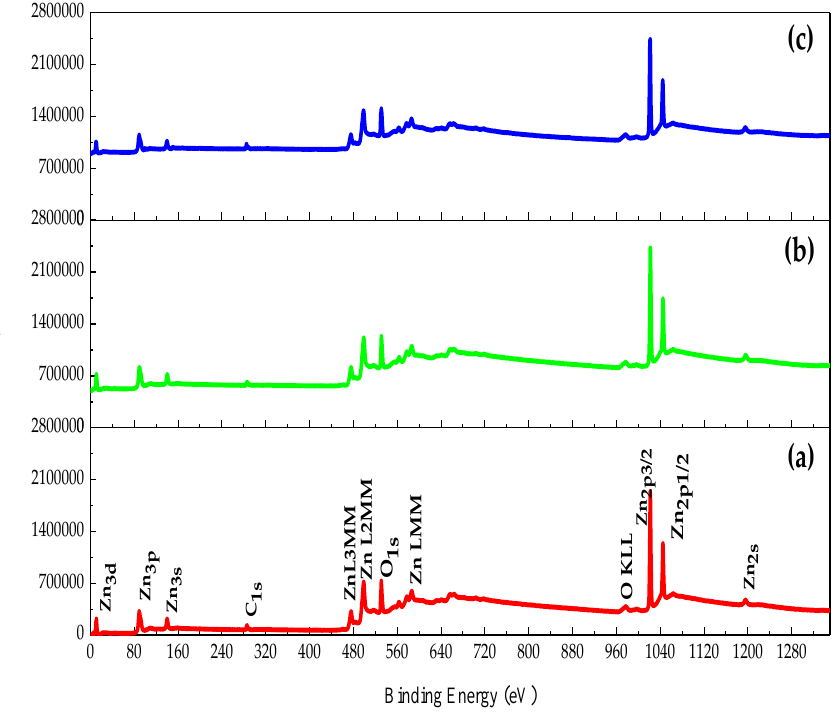
Figure 1. XPS spectra of the ZnO films synthesized on silicon substrate: ( a ) substrate heated at 200 °C, ( b ) substrate heated at 300 °C, ( c ) substrate heated at 400 °C.